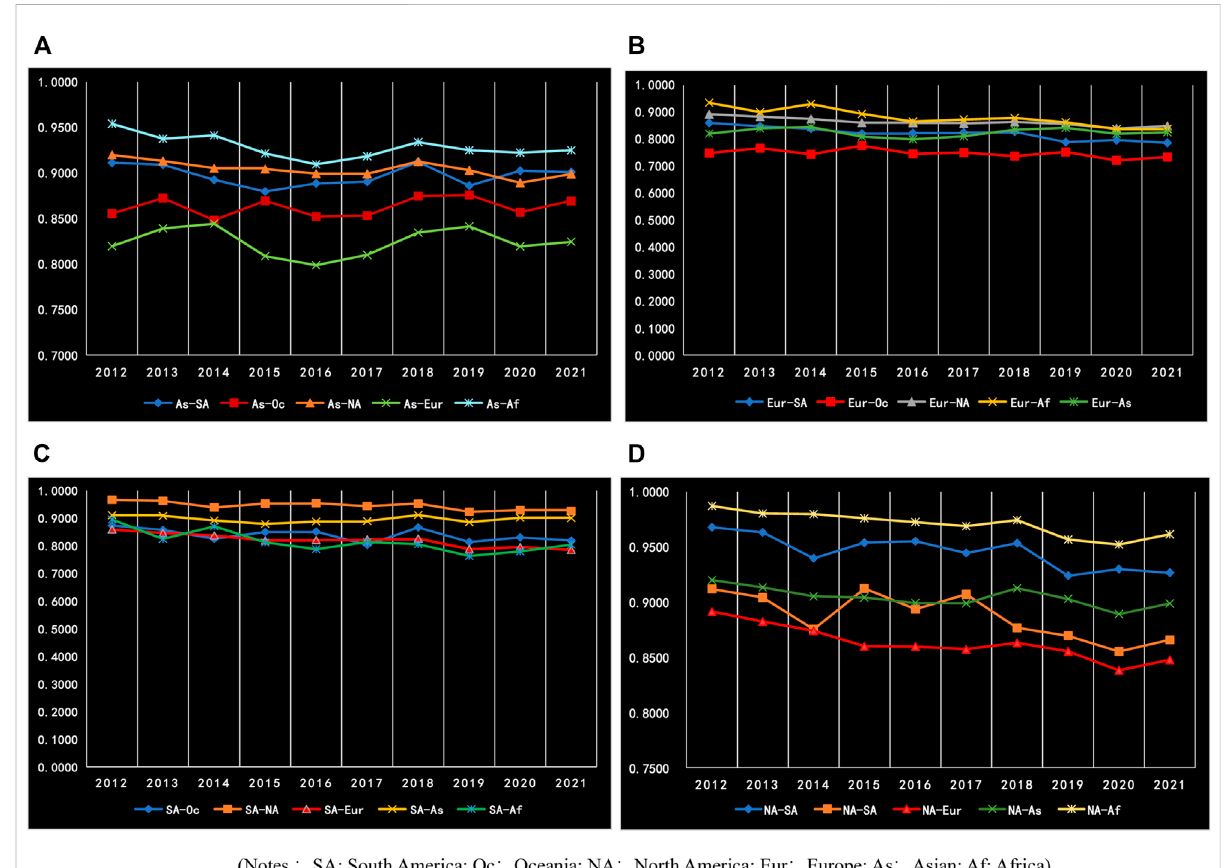
FIGURE 5 (A – D) respectivelyshow theevolution ofintercontinentaldifferencesinremote sensing researchoutputbetweenAsia,Europe,South America, and North America and other continents. (Notes.: SA: South America; Oc: Oceania; NA: North America; Eur: Europe; As: Asian; Af: